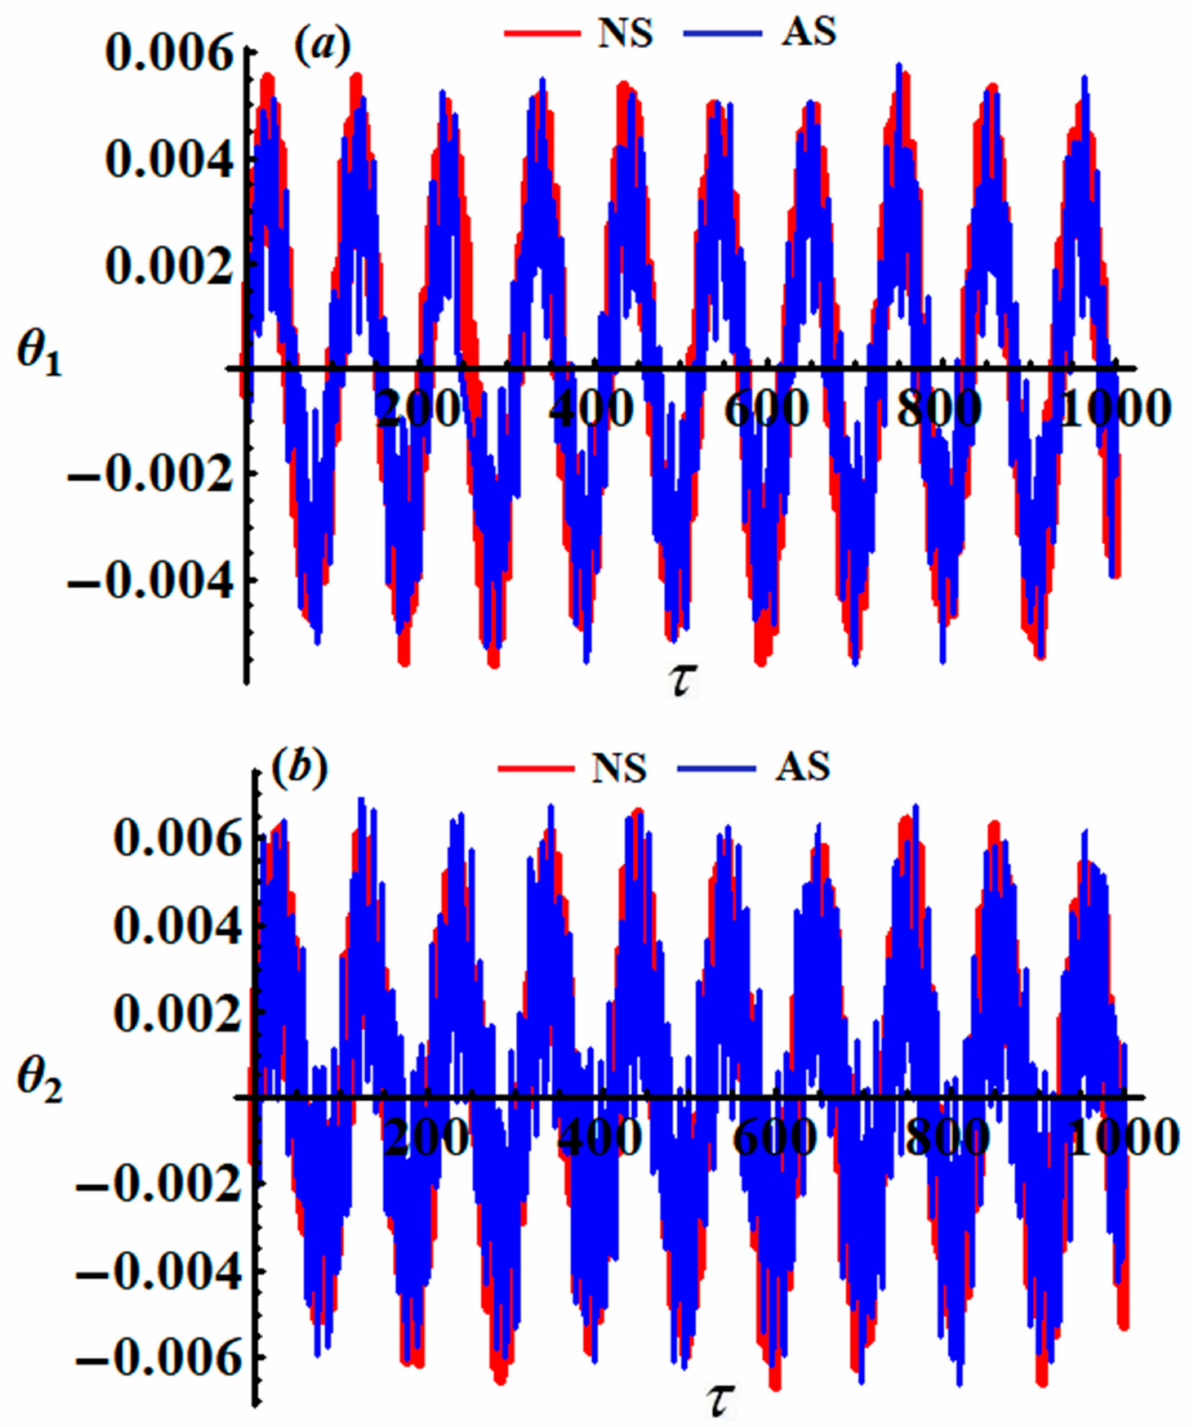
Figure 6. Representation of a comparison between the AS and the NS at ω 1 = 3.3 and ω 2 = 4.4: ( a ) for θ 1 , ( b ) for θ 2